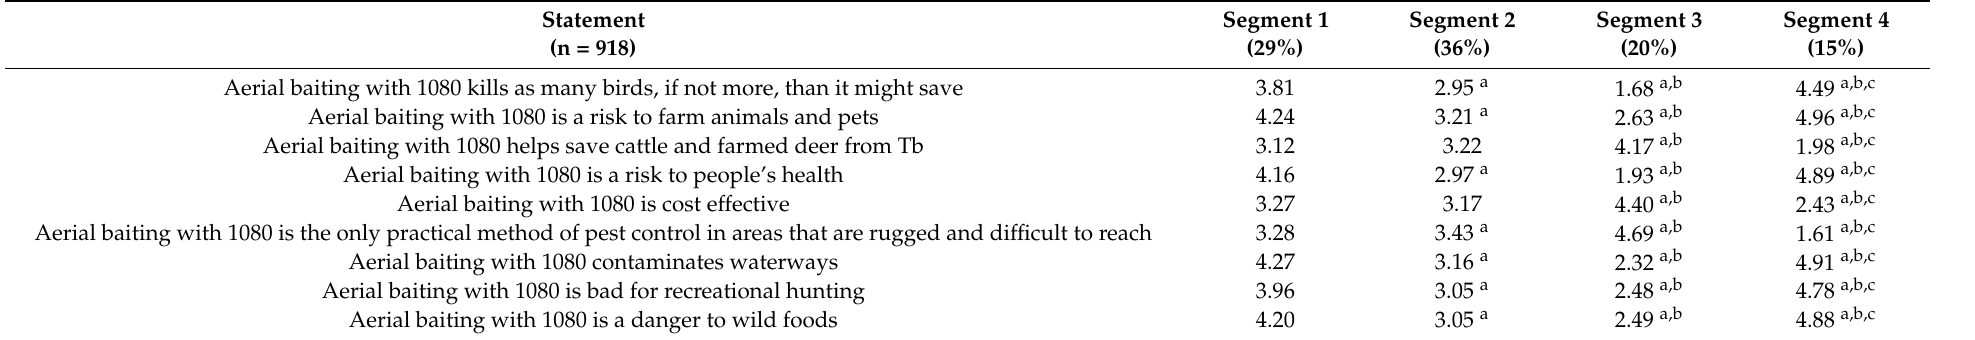
Table 5. Belief segments about aerial baiting with